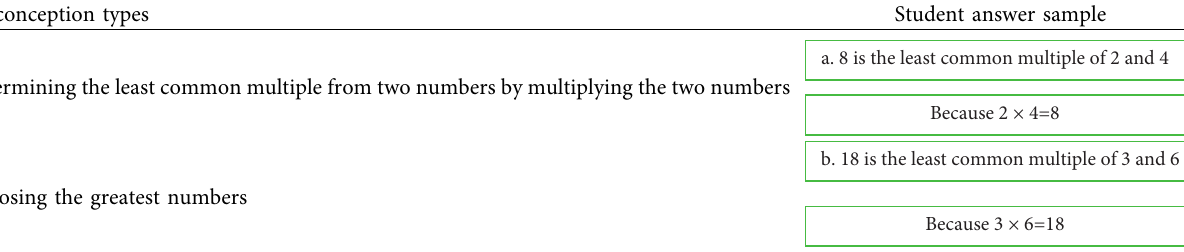
Table 11: Students misconception in question 5 and its answer category.